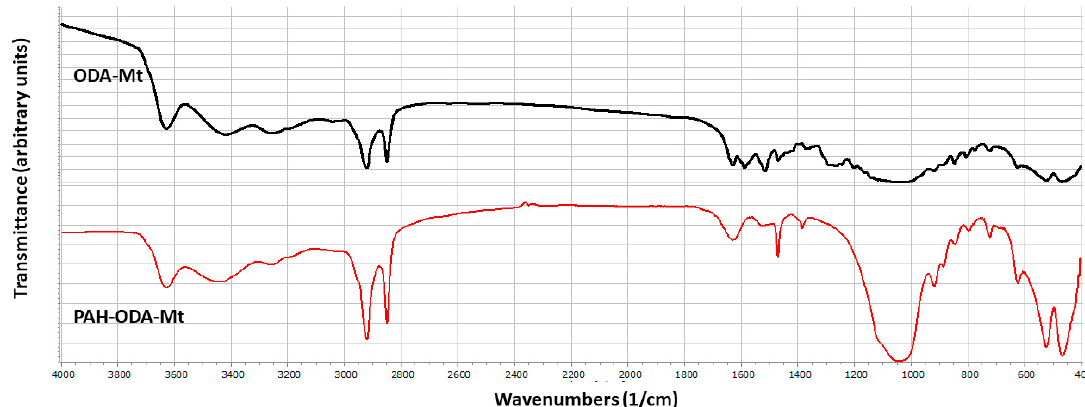
Figure 2. FT-IR transmittance spectra of ODA-Mt before and after adsorption assays in 4000–400 cm − 1 Figure 2. FT ‐ IR transmittance spectra of ODA ‐ Mt before and after adsorption assays in 4000–400 cm − 1 region.